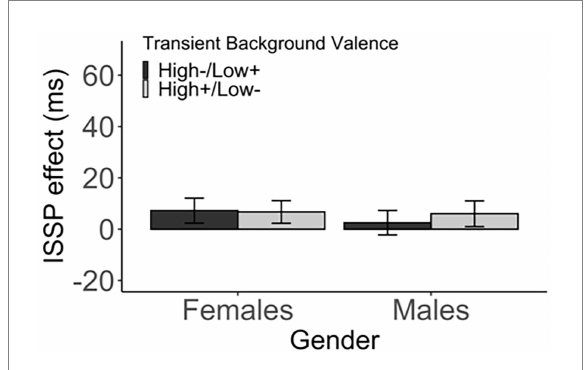
FIGURE 6 The ISSP effect (in ms) as a function of the transient background valence and gender. Error bars indicate the standard error of the